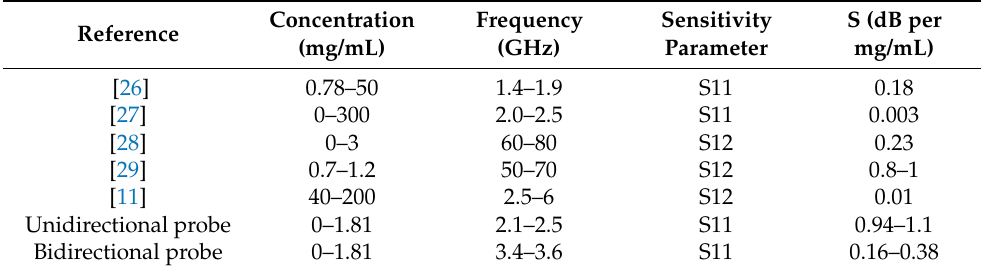
Table 5. Sensitivity values of analog devices for non-invasive